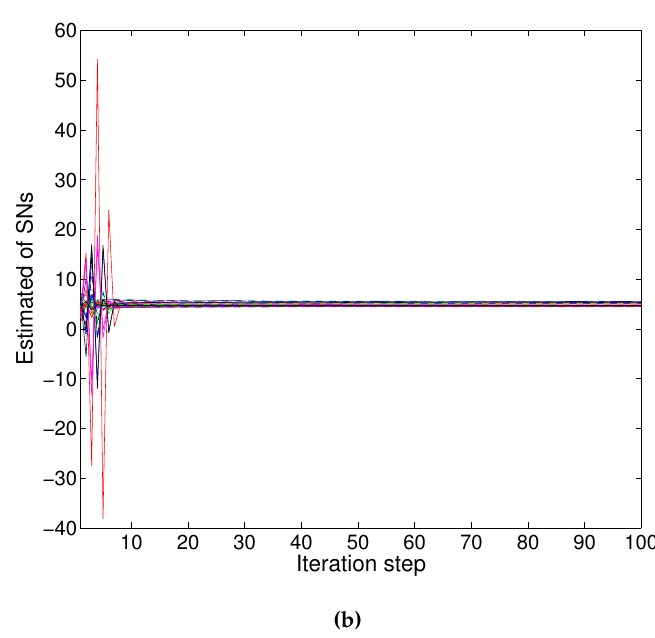
Figure 5. Convergence of PACS in numerical Example 2: ( a ) without attackers; ( b ) with three attackers.